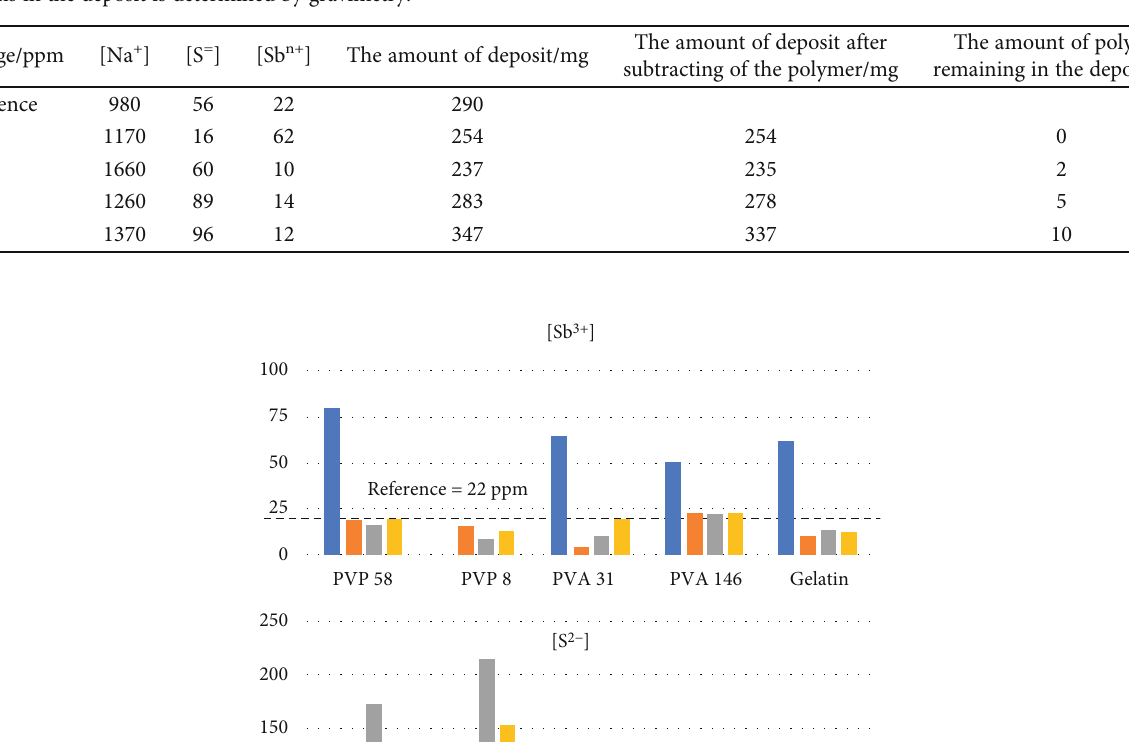
Table 3: The e ff ect of Gelatin at various dosages. The concentration of the ions is given in terms of ppm. The amount of polymeric antiscalant remains in the deposit is determined by